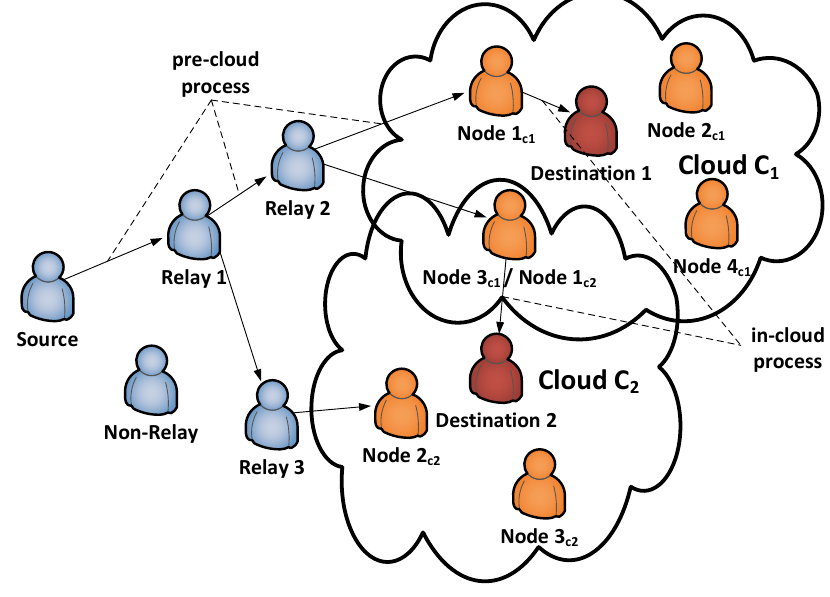
Figure 7 . A cloud-based multicasting scenario in DTN [35]. Figure 7. A cloud-based multicasting scenario in DTN